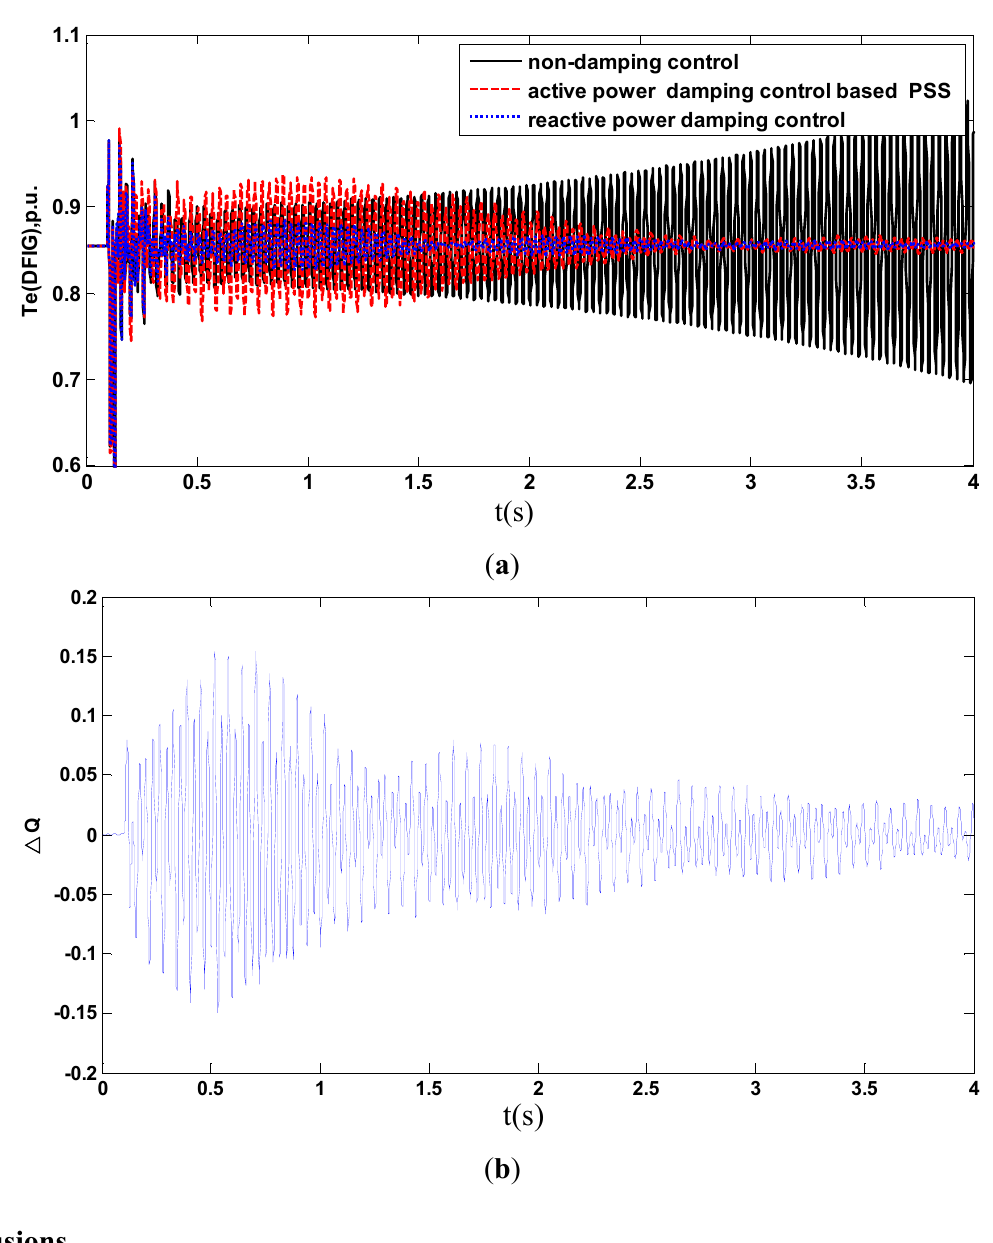
Figure 10. Dynamic performance of the turbo-generator during and after clearing fault, ( a ) Electromagnetic torque response of the wind turbines; ( b ) Supplementary signal output of dynamic reactive power Δ Q added at the reactive power loop of